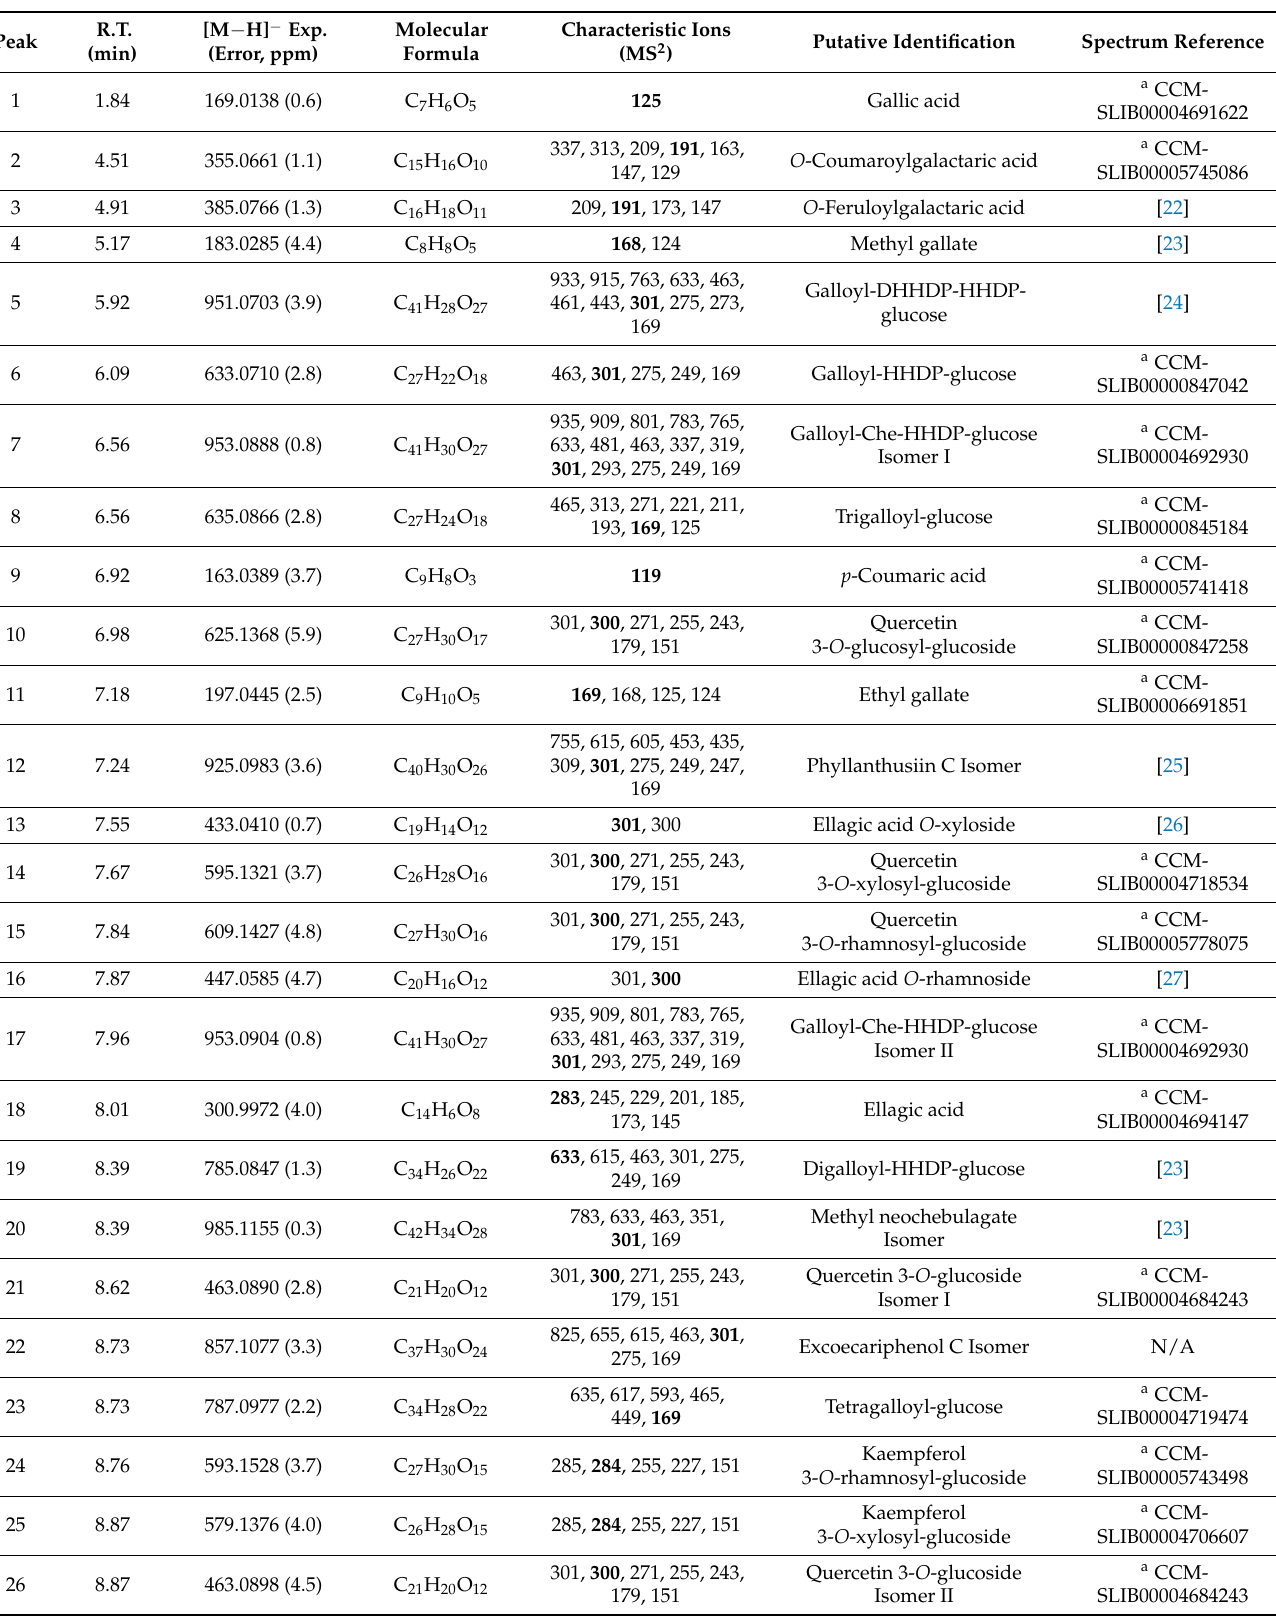
Table 1. Characterization of chemical compound of the extract from the leaves of M. nobilis by UHPLC-MS/MS in negative